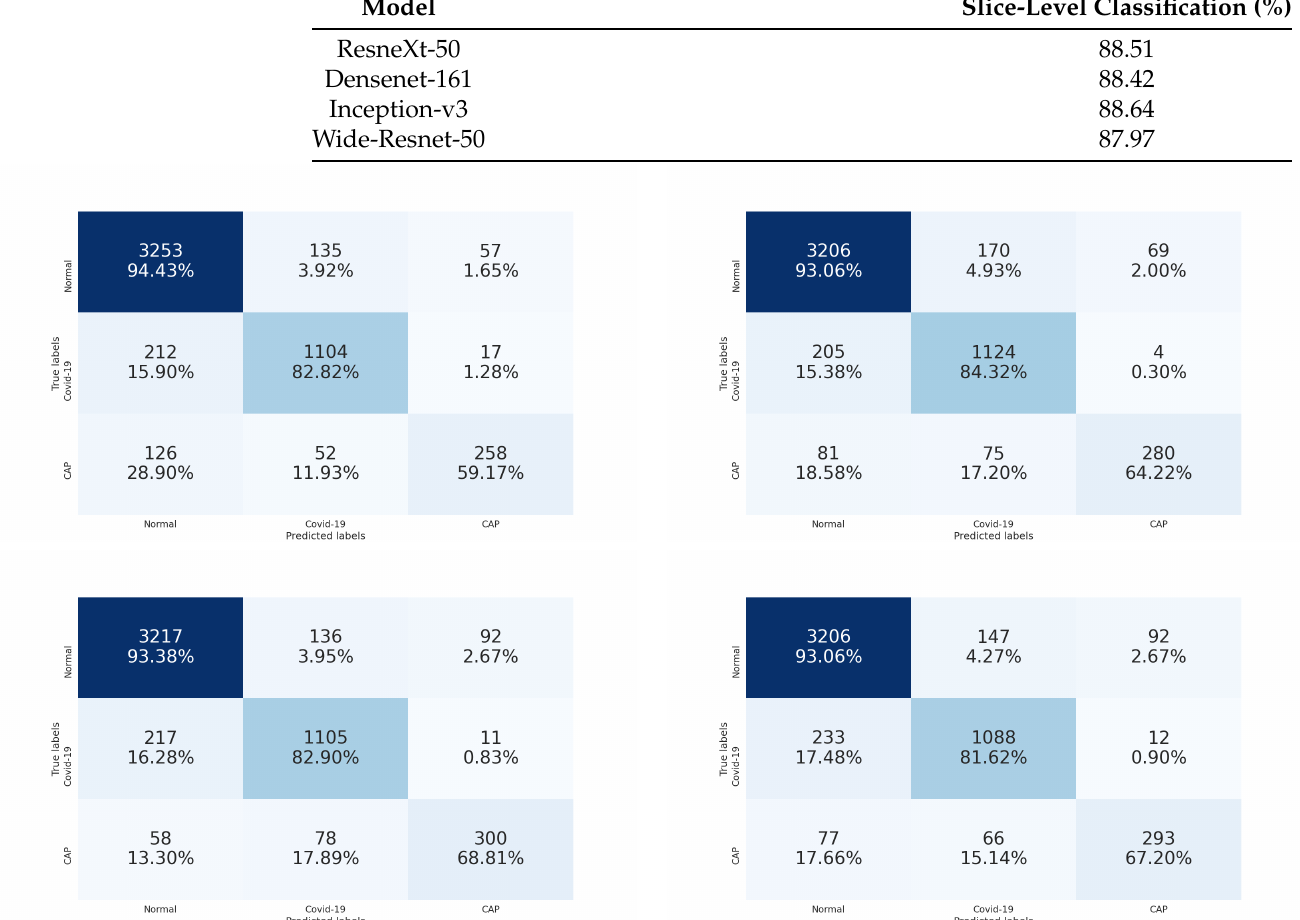
Table 3. Validation slice-level classification results using augmented stacked gray and segmented images scenario with four backbone CNN architectures (ResneXt-50, Densenet-161, Inception-v3, and Wide-Resnet-50).